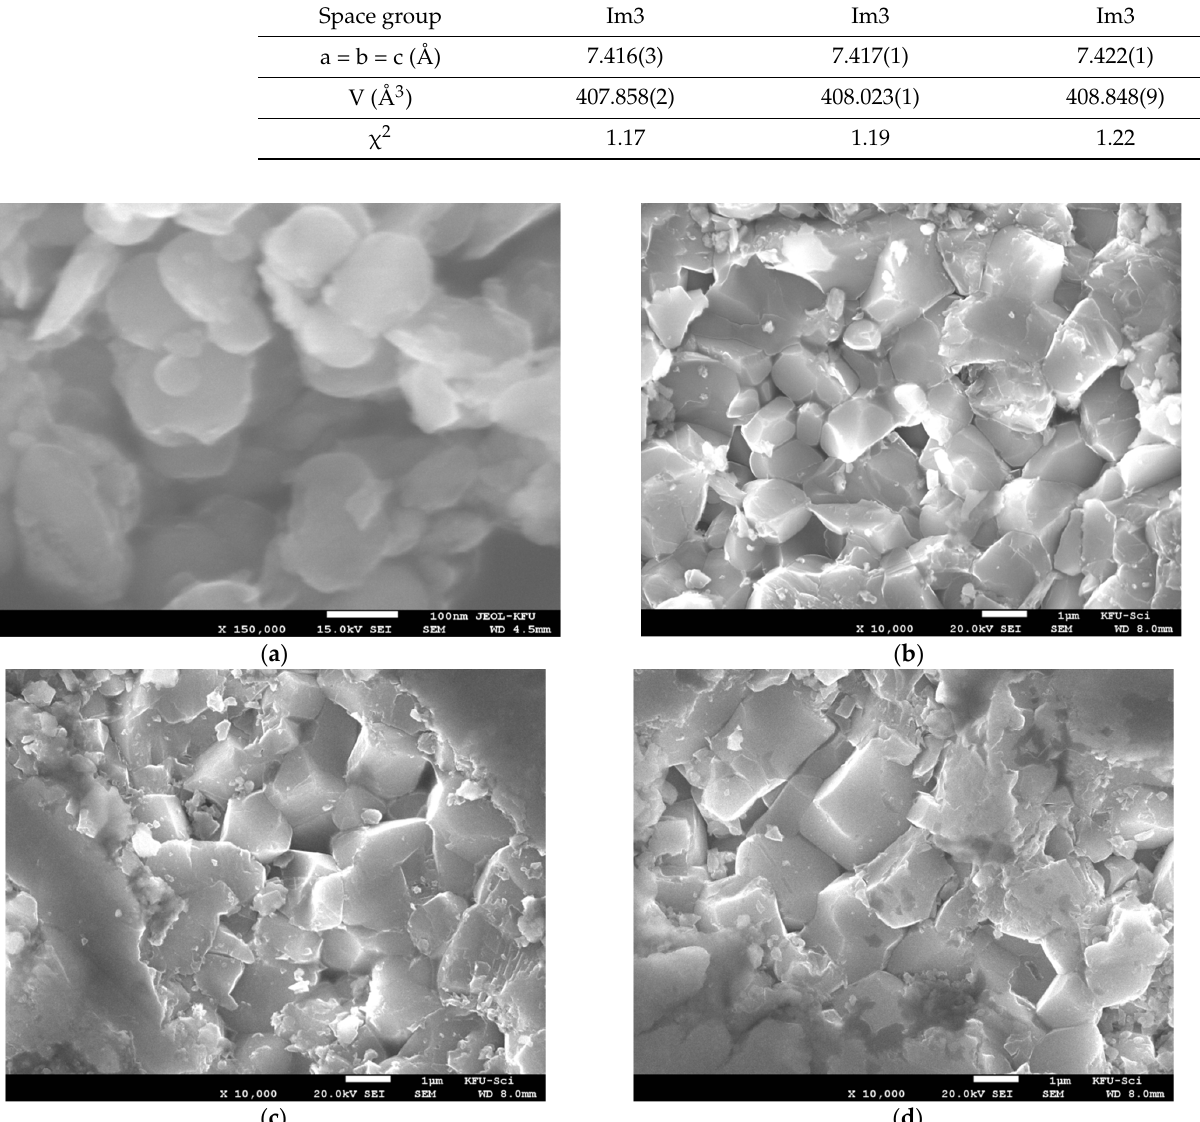
Table 1. Structural parameters obtained from Rietveld refinement of the XRD data of LCTO ceramics.